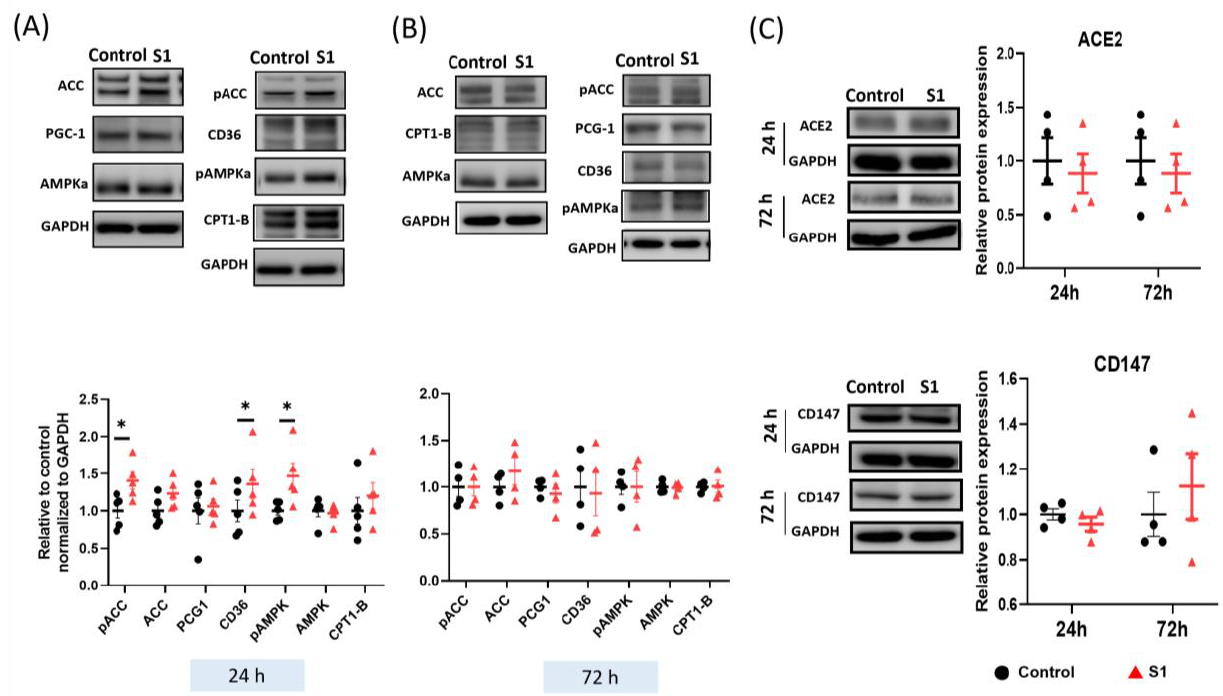
Figure 5. Effects of S1 on the expression of fatty acid transporters and spike protein receptors in AC16 cells after 24 and 72 h treatments. ( A ) S1 (24 h) increased the protein expression of CD36 and phosphorylation of acetyl-coenzyme A carboxylase (ACC) and 5′ -adenosine monophosphate–activated protein kinase catalytic subunit alpha-2 (AMPKa), but not the expression of peroxisome proliferator-activated receptor-gamma coactivator-1 and carnitine palmitoyl transferase 1B, total AMPKa, and ACC ( n = 4 – 6 independent experiments). ( B ) S1 did not alter the expression of fatty acid transporters at 72 h ( n = 4 independent experiments). ( C ) S1 did not change protein expression of CD147 and ACE2 of the SARS-CoV-2 receptors at 24 h and 72 h. n = 4 – 6 independent experiments. Paired t- test was performed to compare the S1 protein-treated and control cells: * p ≤ 0 .05.